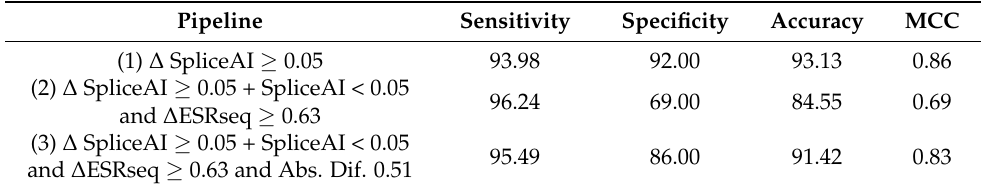
Table 2. Prediction performances of SpliceAI alone and sequentially combined with ESRseq tool with 233 intronic variants from the literature database (133 altering and 100 non altering splicing). Abs. Dif.: absolute